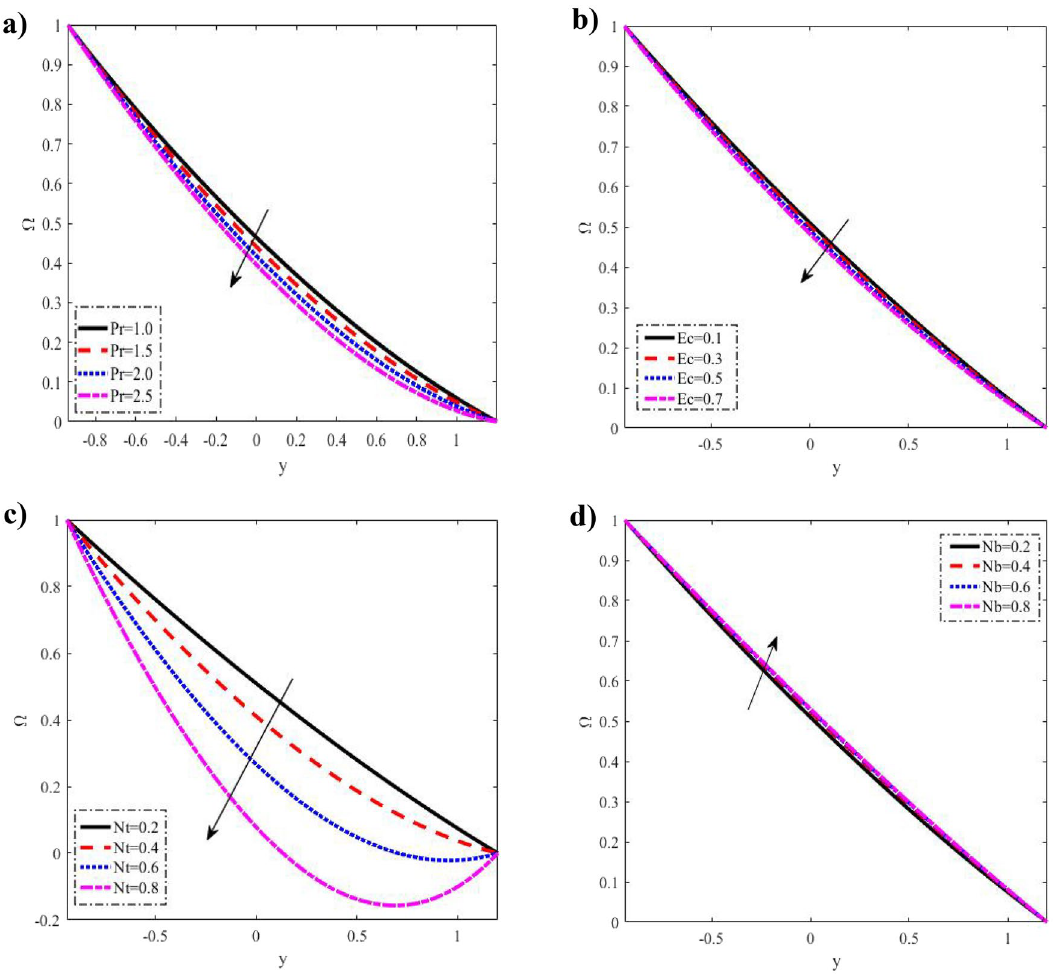
Figure 4. Discrepancies of the concentration (cid:31) against the y-axis. ( a ) For different values of Pr . ( b ) For different values of Ec . ( c ) For different values of Nt . ( d ) For different values of Nb